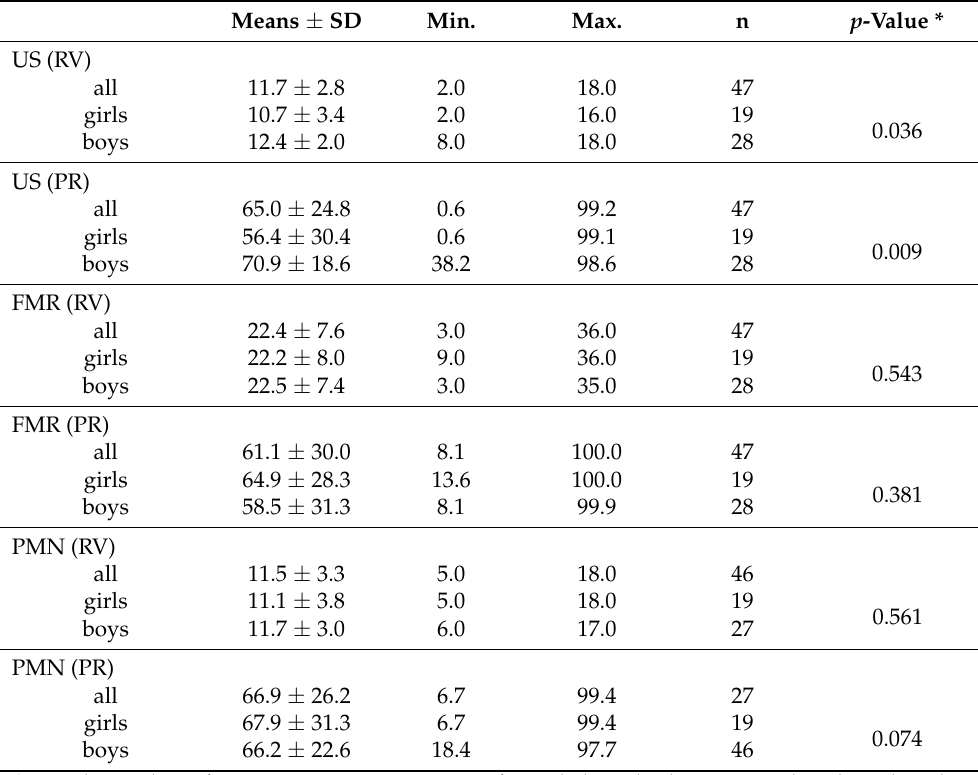
Table 3. Results of the language development test SETK 3–5 overall and separated by gender. Means ± SD Min. Max. n p -Value